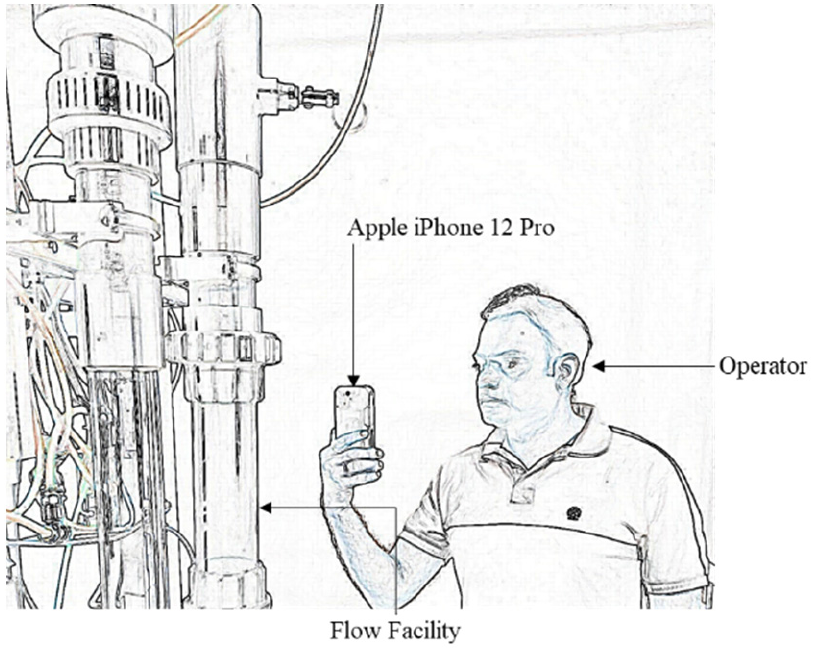
Figure 15. An example of operator visualizing the gas core using an AR handheld device.